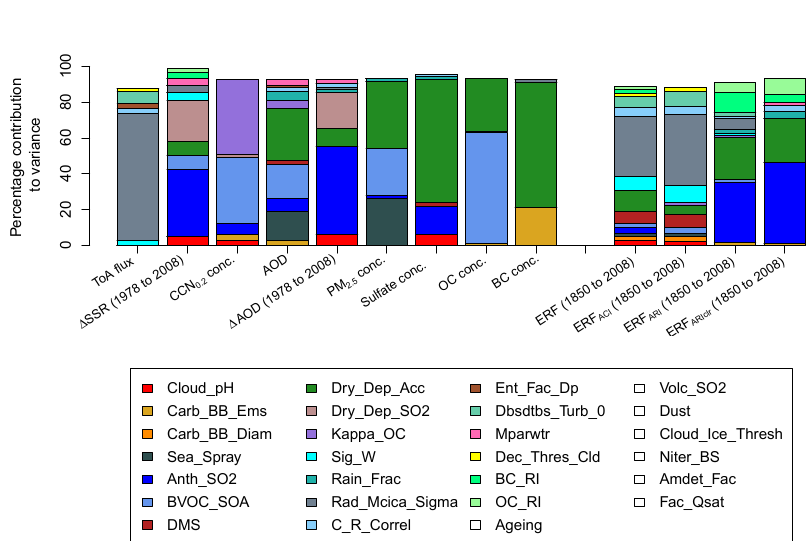
Figure 4. Variance-based sensitivity analysis results, showing the percentage parameter contributions to model output uncertainty in the observable aerosol quantities and the forcing variables for Europe in July. Only those parameters which cause at least 1% of the variance are shown in